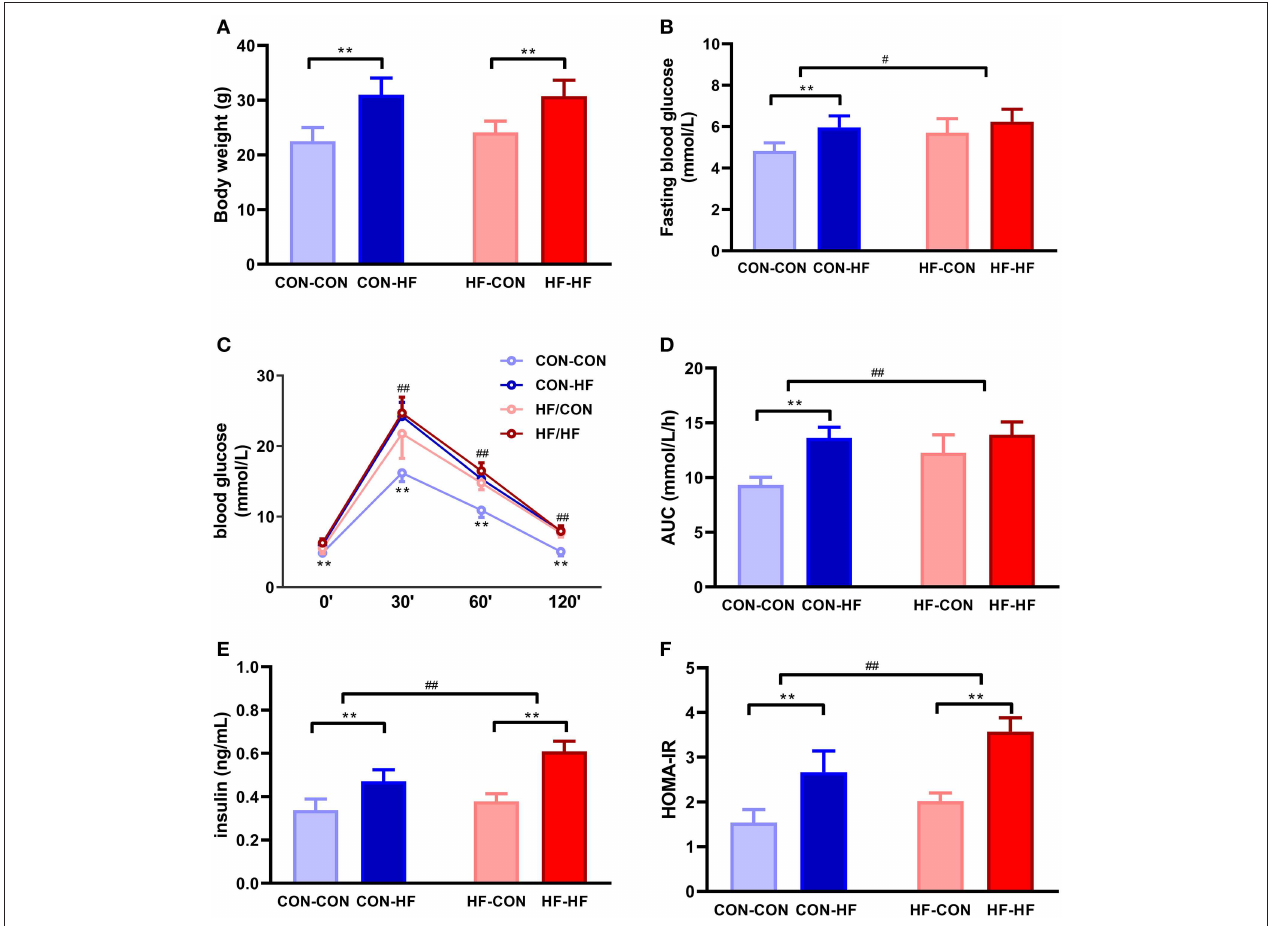
FIGURE 2 | The effect of maternal high-fat diet on metabolic variables of male mice offspring. (A) body weight at weaning; (B) fasting blood glucose; (C) oral glucose tolerance test (OGTT); (D) area under curve (AUC) in OGTT; (E) plasma insulin; (F) HOMA-IR. ** P < 0.01 offspring diet effect; # P < 0.05; ## P < 0.01 maternal diet effect. Values are mean ± SEM ( n = 10). CON-CON: control diet mother-post-weaning control diet; CON-HF, control diet mother-post-weaning high-fat diet; HF-CON, high-fat diet mother-post-weaning control diet; HF-HF, high-fat diet mother-post-weaning high-fat